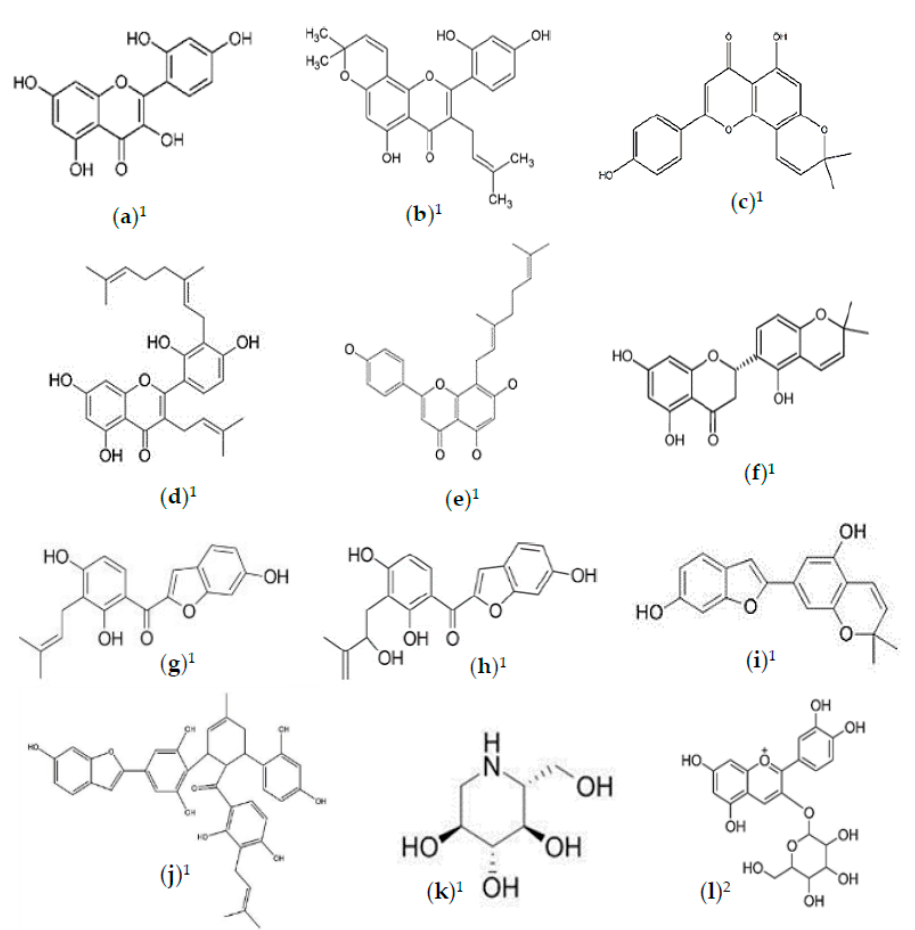
Figure 6. Natural compounds in M. alba with anticancer abilities. ( a ) Morin; ( b ) morusin; ( c ) atalantoflavone; ( d ) 3 ′ -geranyl-3-prenyl-2 ′ ,4 ′ ,5,7-tetrahydroxyflavone; ( e ) 8-geranylapigenin; ( f ) sanggenon K; ( g ) morachalcone B; ( h ) morachalcone C; ( i ) moracin D; ( j ) chalcomoracin; ( k ) 1-deoxynojirimycin (DNJ); ( l ) cyanidin-3-glucoside. 1 Refers to compounds in M. alba leaves; 2 refers to compounds in M. alba fruit.